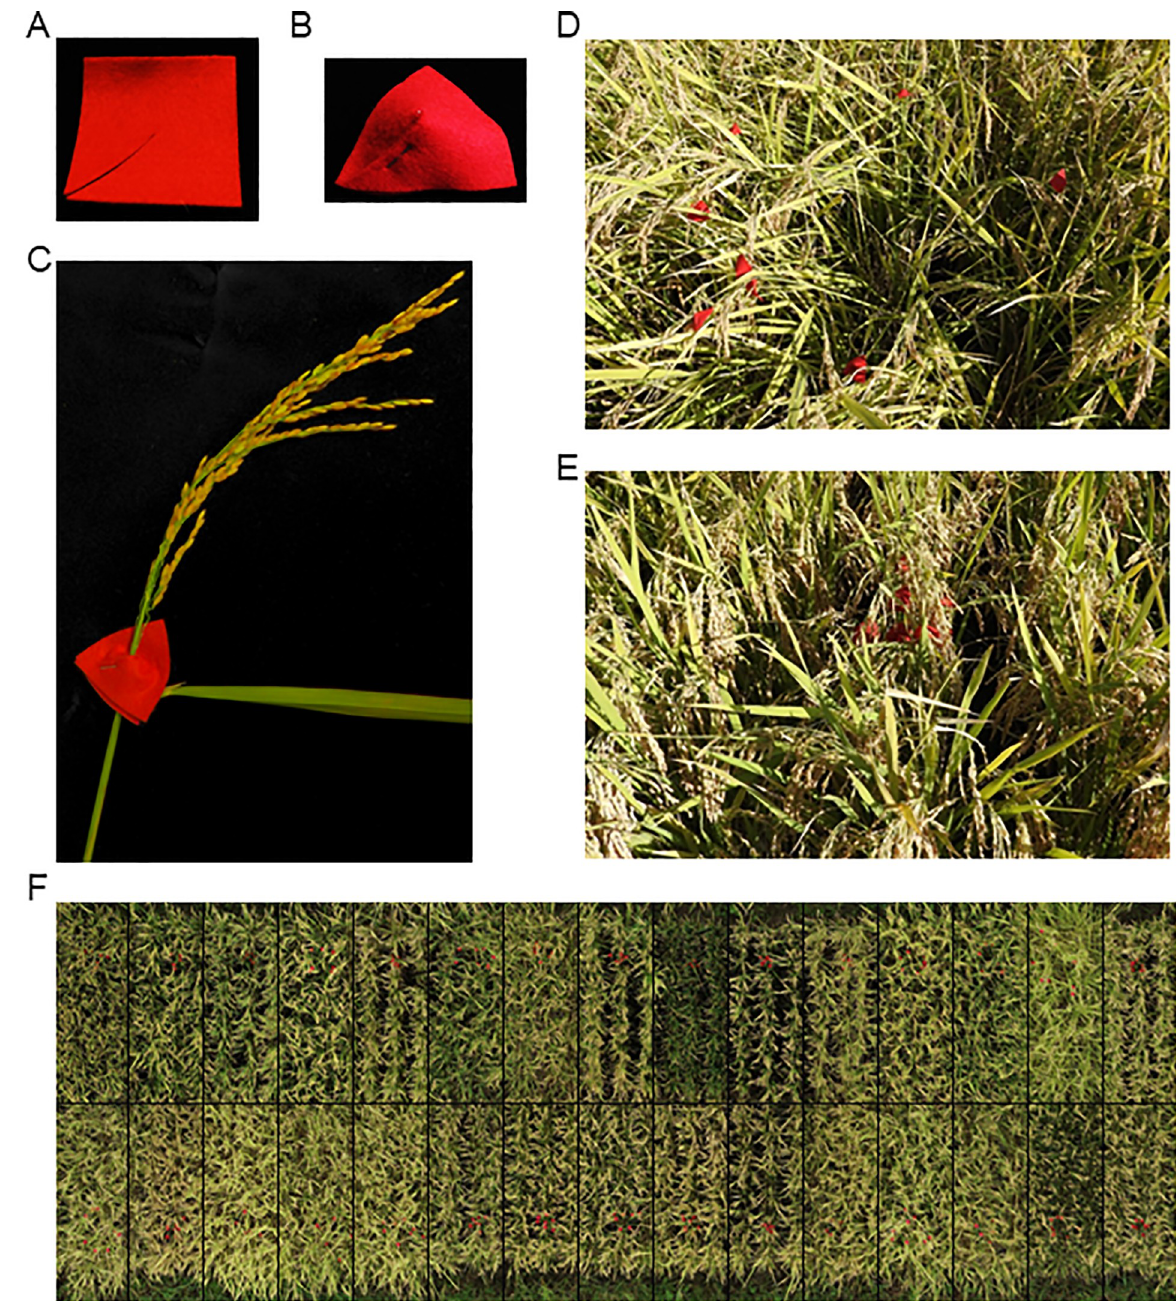
Fig 2. Red flags attached to panicle bases. (A) A square of red felt (4.5 cm × 4.5 cm) was cut from one corner to the center by scissors and (B) stapled around (C) a panicle base. (D, E) The spread of the red flags on the panicles depended on the HOMI-RIL (photographed from above). (F) The red flags were attached to every third plant in the middle row. This orthomosaic was made from photographs taken on 20 September 2018. The black lines delineate the HOMI-RILs.